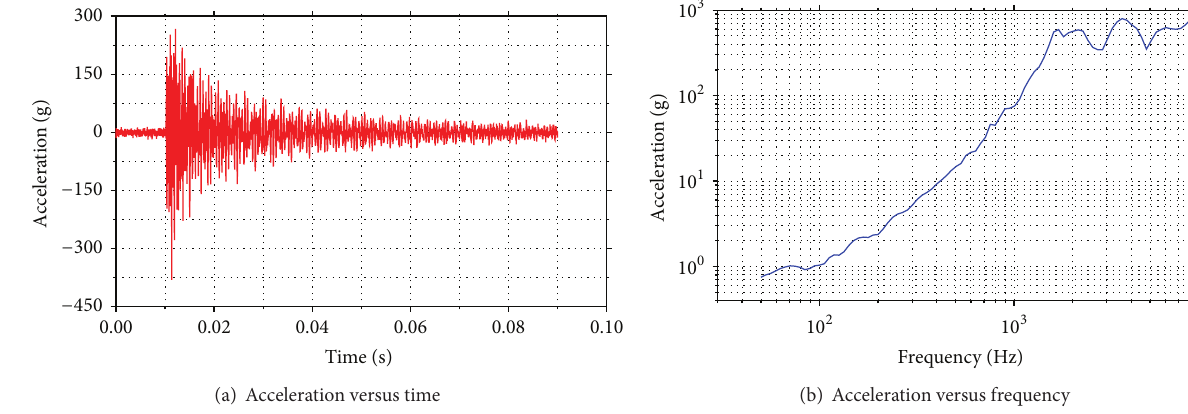
Figure 4: Typical experimental